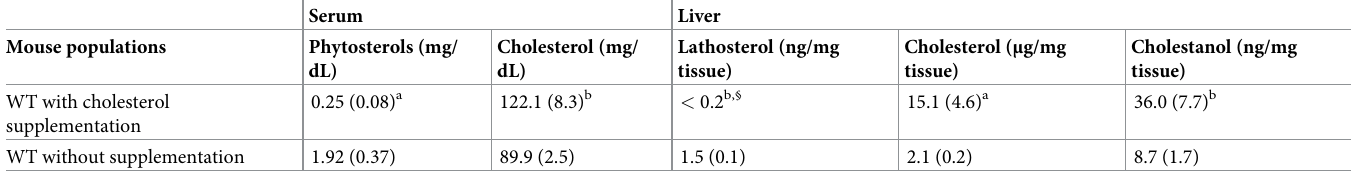
Table 1. Comparison of sterol levels in WT mice with and without cholesterol-supplementation.